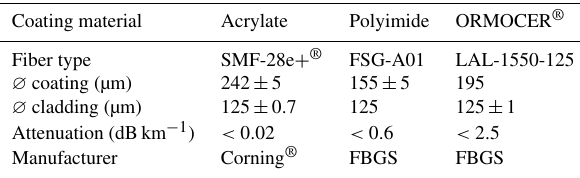
Table 2. Concrete mixture for the shrinkage tests based on Dycker- hoff GmbH (2017).